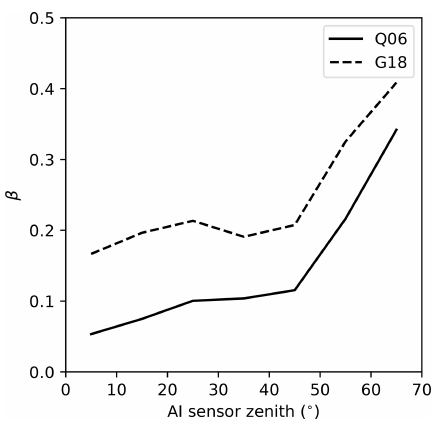
Figure 3. Susceptibility ( β ) as a function of MODIS sensor zenith angle for the aerosol index (AI) retrieval for two different droplet number concentration ( N d ) sampling strategies – Q06 (based on Quaas et al., 2006) and G18 (based on Grosvenor et al., 2018) – in the south-east Pacific. Note that different sensors are used for the N d and AI retrievals so that the N d retrieval is close to nadir, min- imising error in the retrieval (Grosvenor et al., 2018; Gryspeerdt et al.,